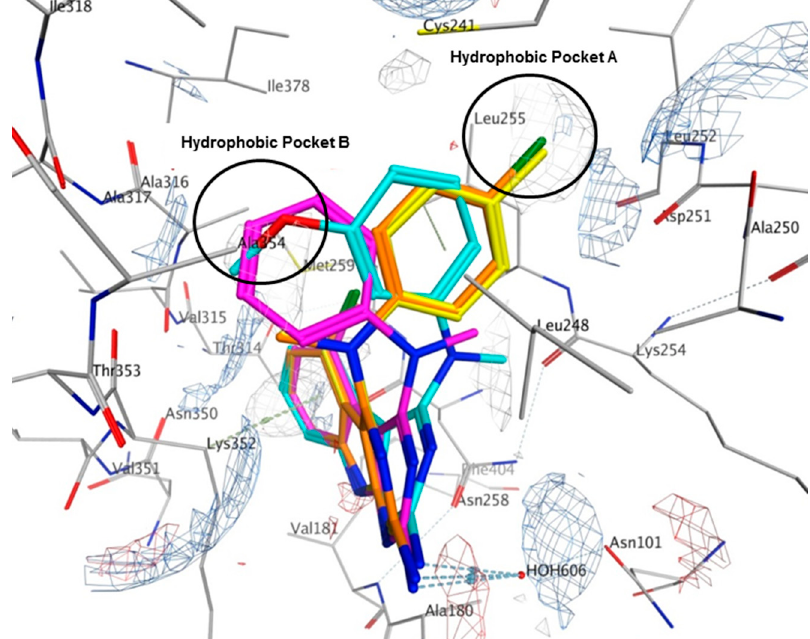
Figure 8. Docked poses of 1 (cyan), 2 (yellow), 3 (magenta) and 4 (orange) in the colchicine site of tubulin (PDB ID: 4O2B). Electrostatic map with electropositive charges in blue, electronegative charges in red and hydrophobic regions in gray.